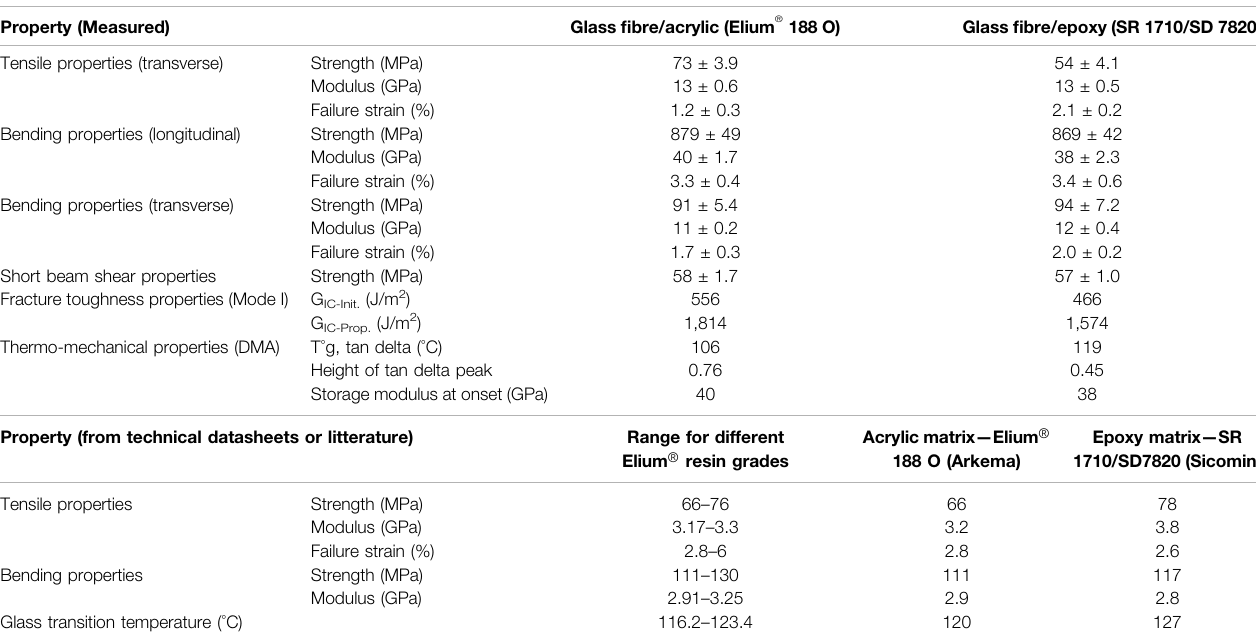
TABLE 1 | Benchmarking of E-glass fi bre/acrylic against E-glass fi bre/epoxy vacuum-infused laminates and corresponding matrix resins — Tensile, bending, shear, mode I interlaminar fracture toughness and thermomechanical properties (adapted from Obande et al., 2019 and Obande and Bradaigh, 2021). Property